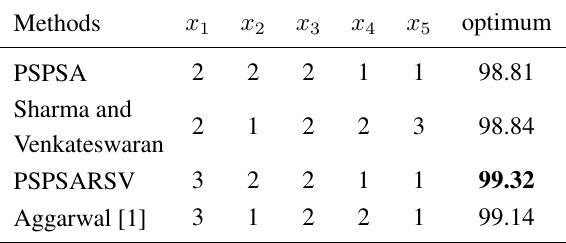
Table 1: Performance of PSPSARSV on five bridge sys-